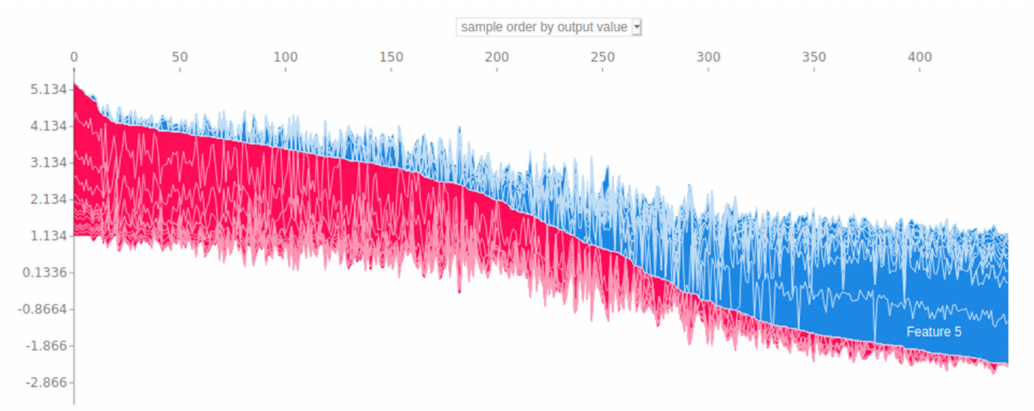
Figure 12. Explanation of many predictions by output